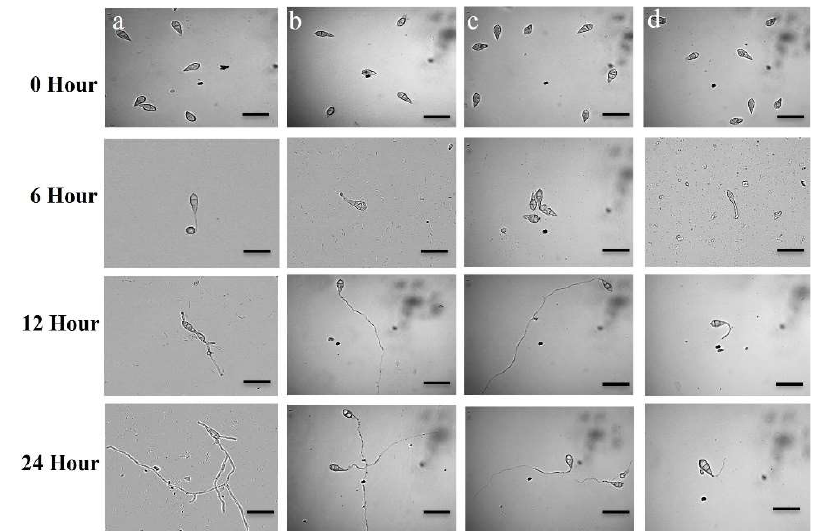
Figure 5. Time-dependent observation of germination of conidia of Magnaporthe oryzae Triticum and their subsequent morphological changes in the control plate ( a ), presence of staurosporine ( b ), chelerythrine chloride ( c ), and the commercial fungicide, Nativo ® 75WG ( d ). Dose of chelerythrine chloride, staurosporine, and Nativo ® 75WG was 0.05 µg/mL. Bar = 10 µm.